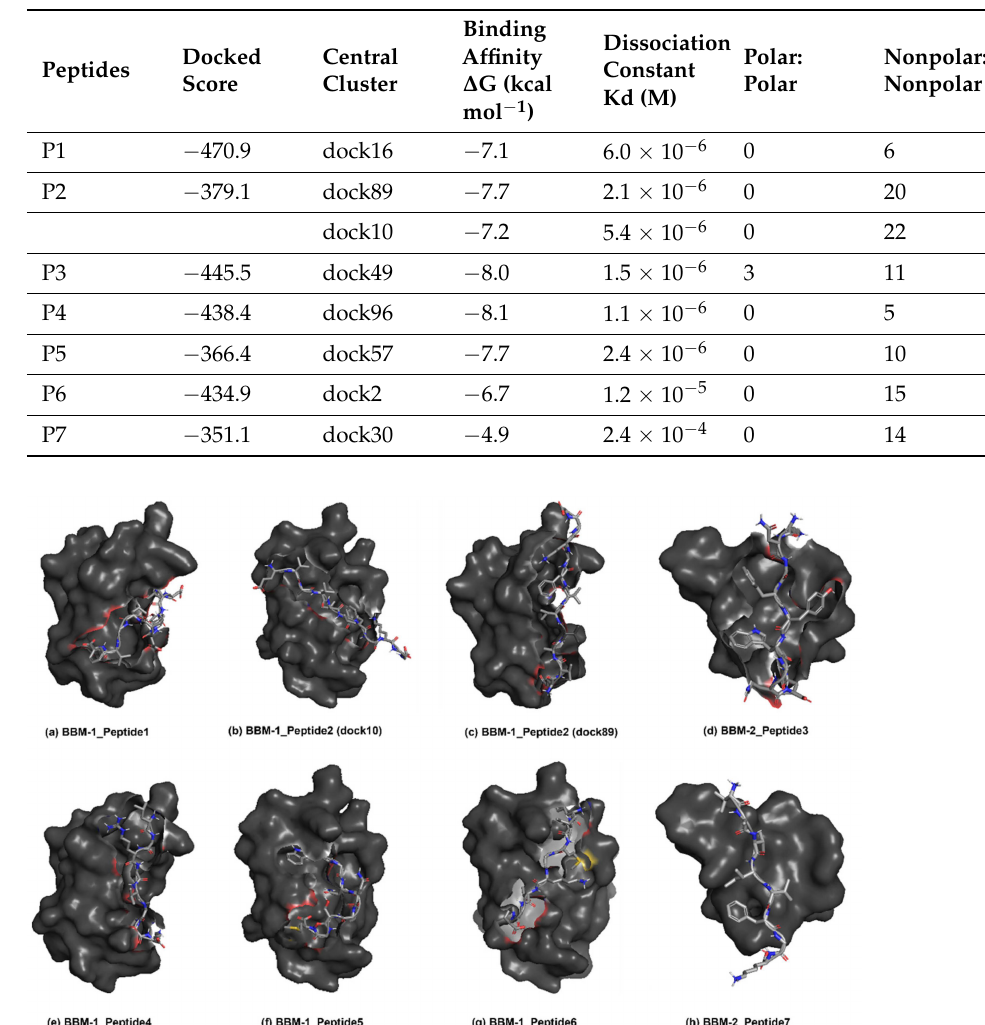
Figure 6. Best 3D conformation of selected 7 peptides (P1–P7) modeled using APPTEST server. Peptides are shown from top to bottom as N-terminal to C-terminal. Table 6. Docked score of the peptide and BBM protein complex with its binding energy, dissociation constant, polar-polar, and nonpolar-nonpolar contacts’ number.